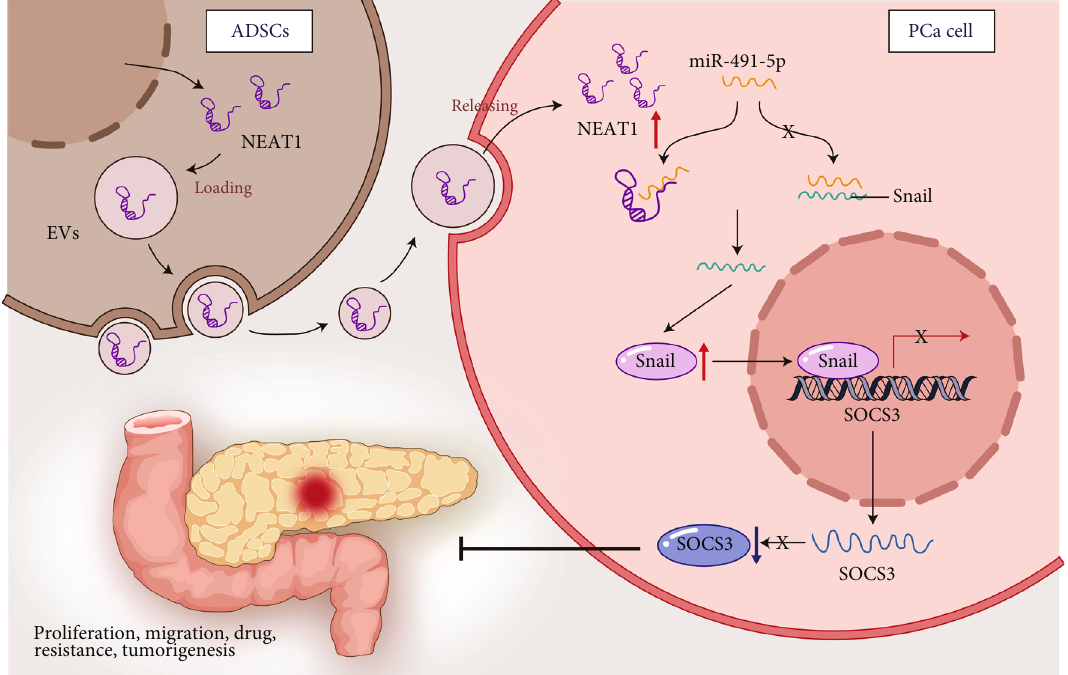
Figure 8: Molecular mechanism of NEAT1 shuttled by ADSC-derived EVs on malignant phenotypes and gemcitabine resistance of PCa via miR-491-5p/Snail/SOCS3 axis.